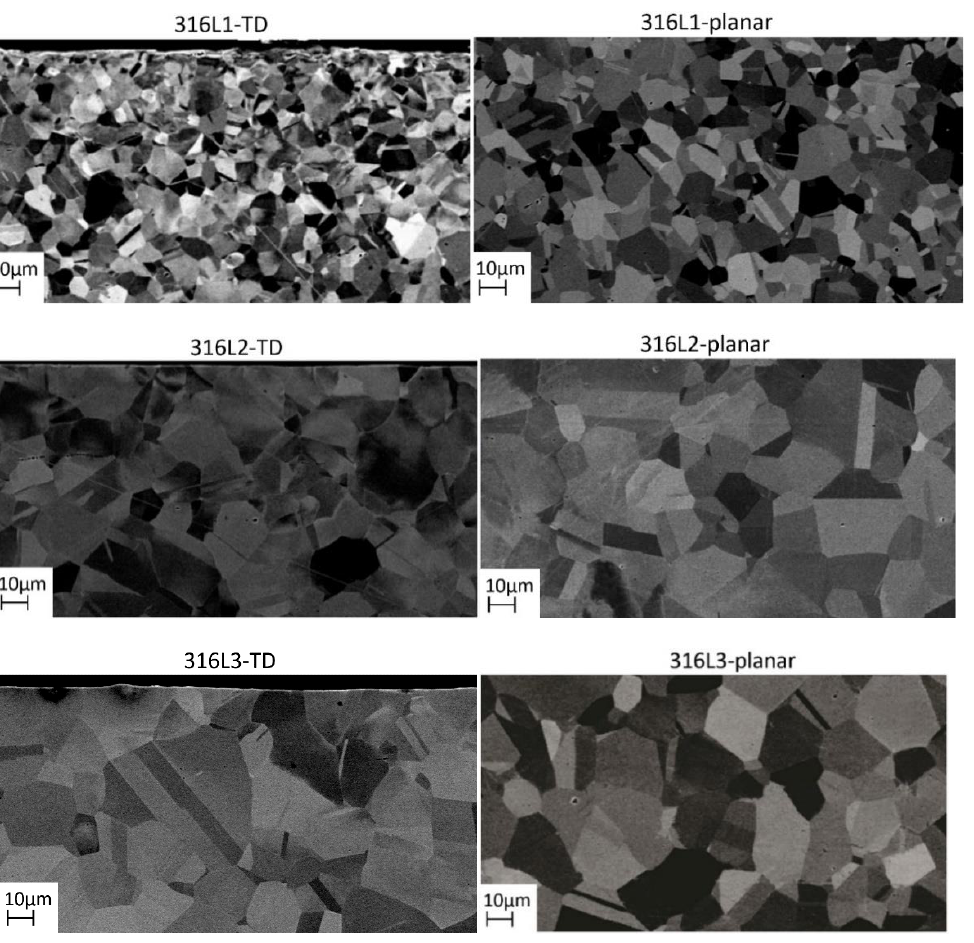
Figure 8. SEM microstructure images taken over the material thickness in the TD and normal direction (Sections 1 and 3 in Figure 1). Table 2. Averaged grain size and thickness to grain size ratio, N, for the commercial and heat treated alloys.